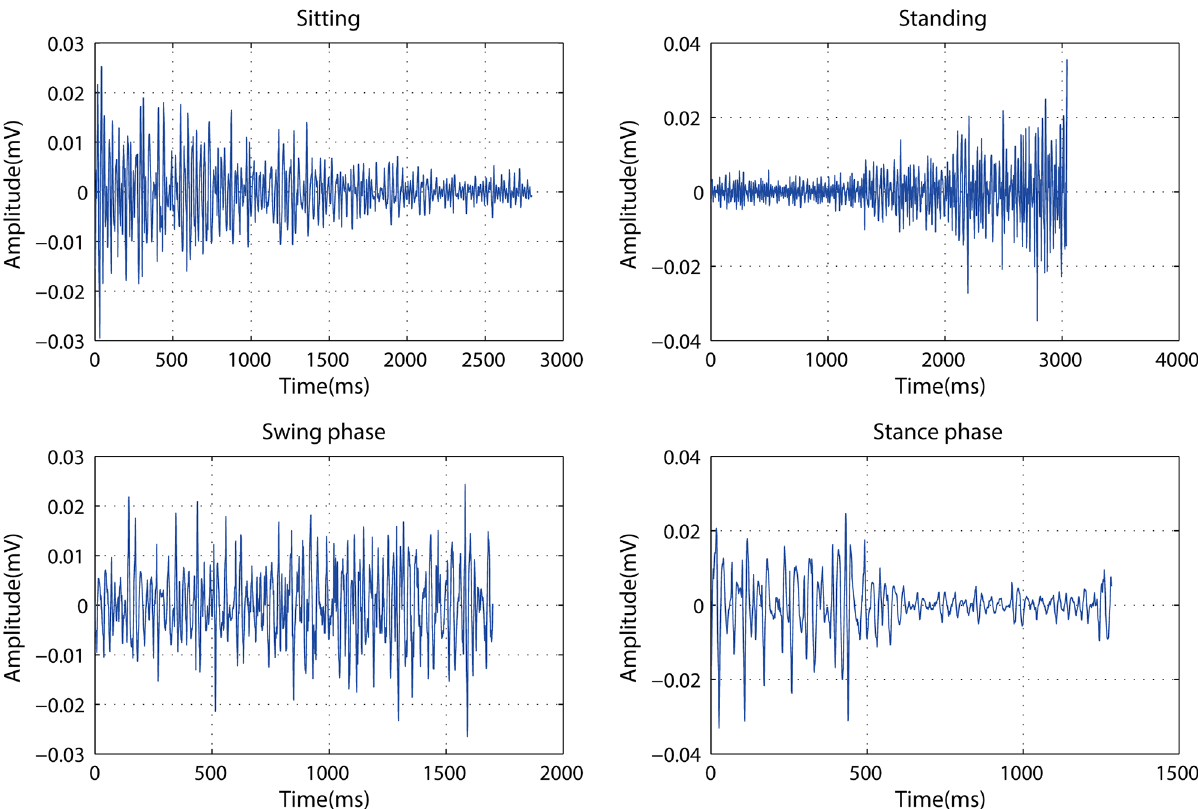
Fig 3. The EMG time series for the segmented lower-limb motions in terms of the swing phase, the stance phase, sitting, and standing.